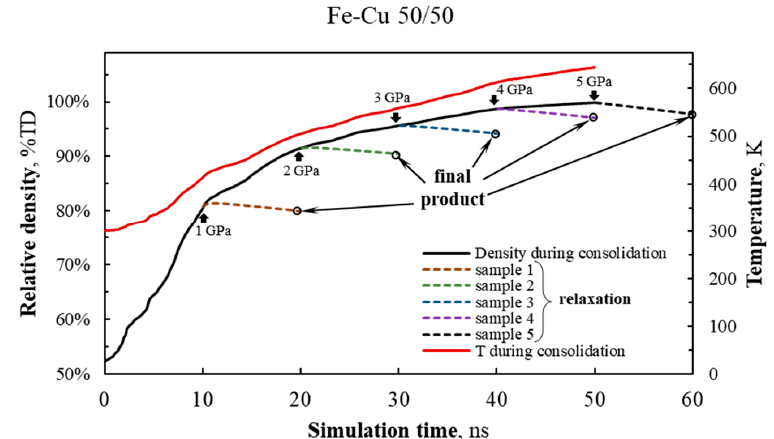
Figure 1. Relative density (solid black line) and temperature (red line) of the 50 / 50 Fe–Cu nanopowder during cold sintering as a function of simulation time. Pressure in the system is given by p ( t )/GPa = 0.1 · t / ns, where t is time. Density change during sample relaxation to normal conditions (# 1, # 2, ... , # 5, obtained at a compaction pressure of 1, 2, ... , 5 GPa) is shown by colored dashed lines.